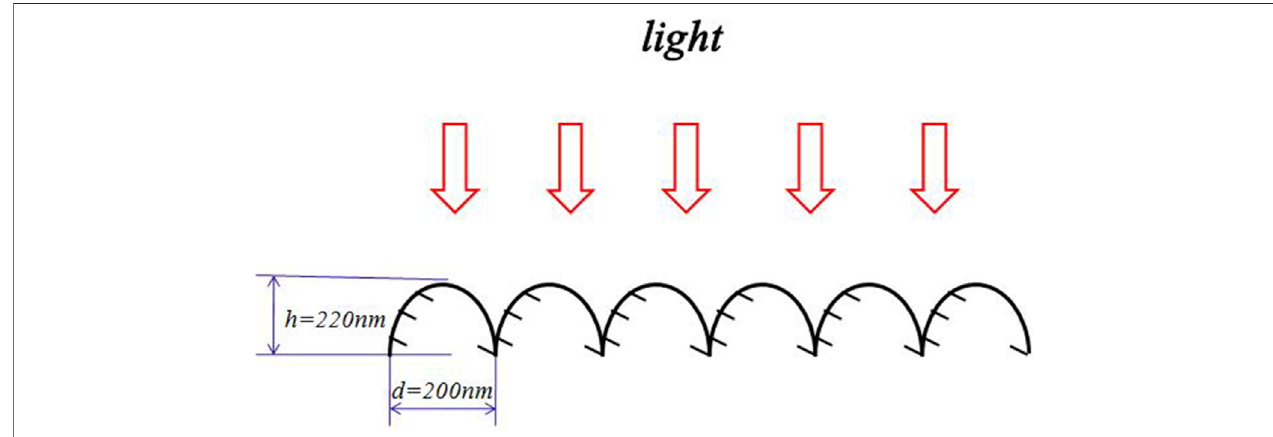
FIGURE 1 | Schematic diagram of the moth-eye effect (Nosonovsky and Bhushan,2013).